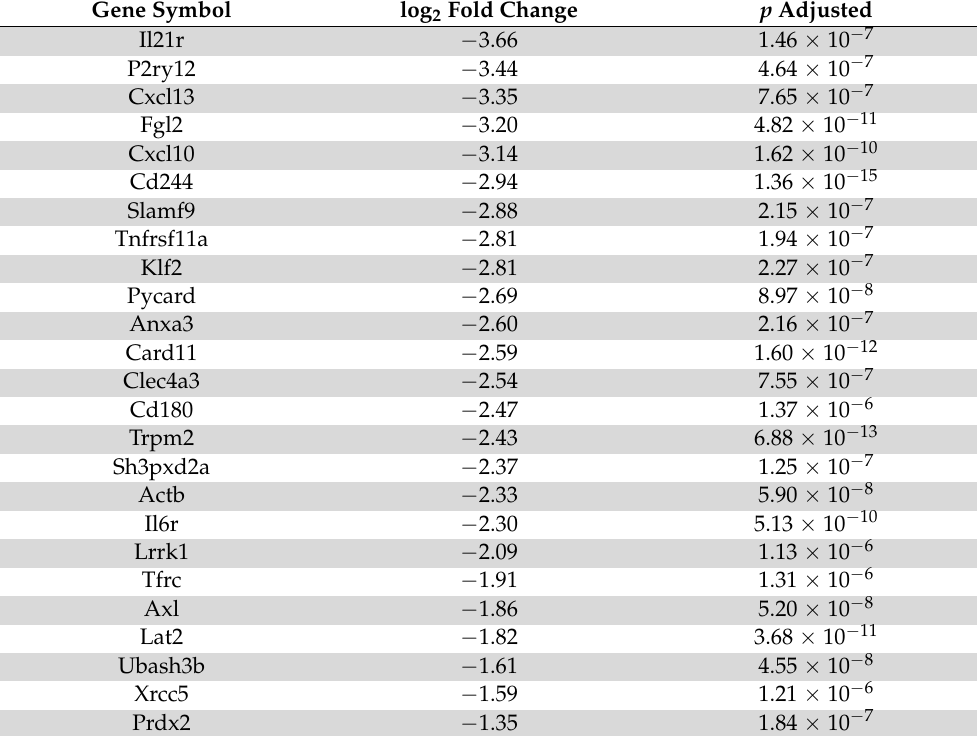
Table 2. Leukocyte activation.